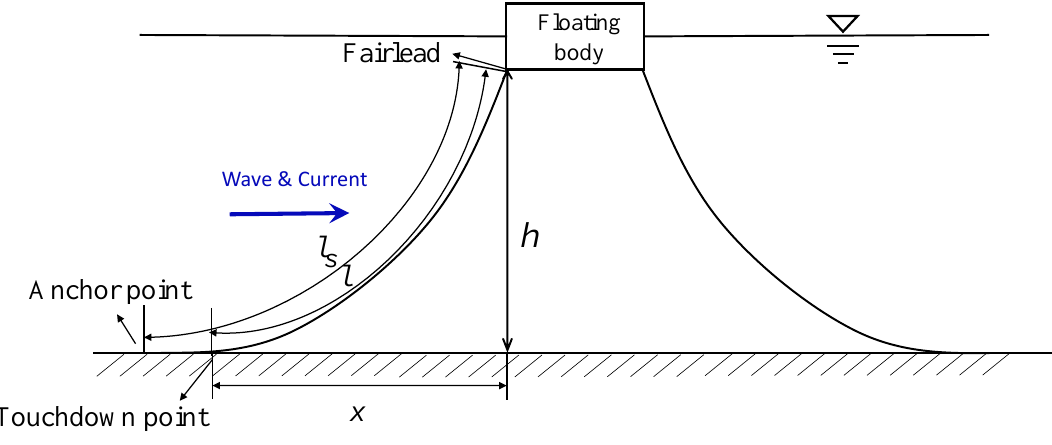
Figure 4. Sketch of catenary mooring line model in the 2D